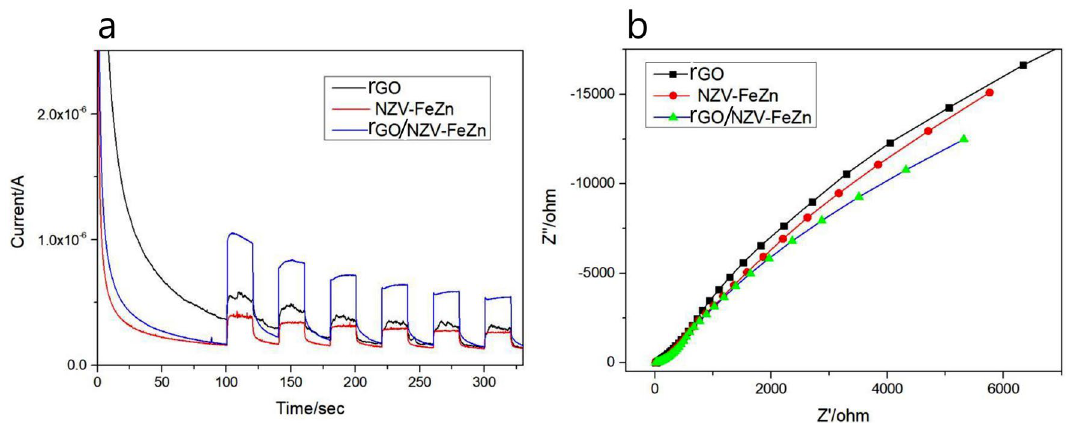
Figure 10. ( a ) Photocurrent response curves recorded under full-wavelength artificial light irradiation and ( b ) Nyquist plots of rGO, NZV-FeZn, and